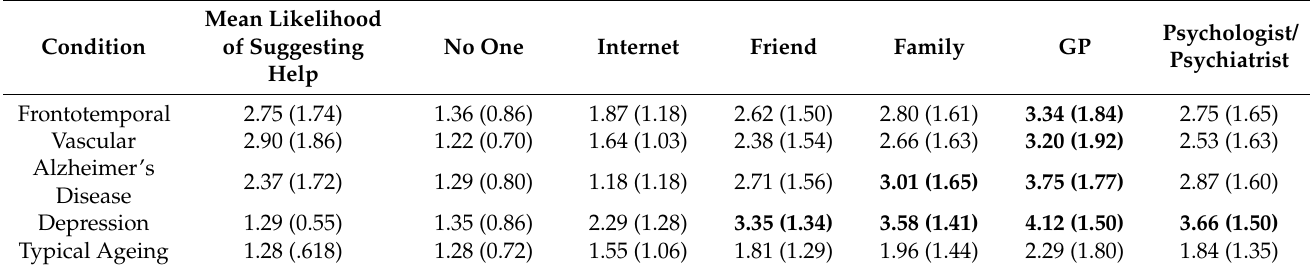
Table 5. Rating of the six help-seeking platforms for the five conditions (mean and SD). Mean Condition